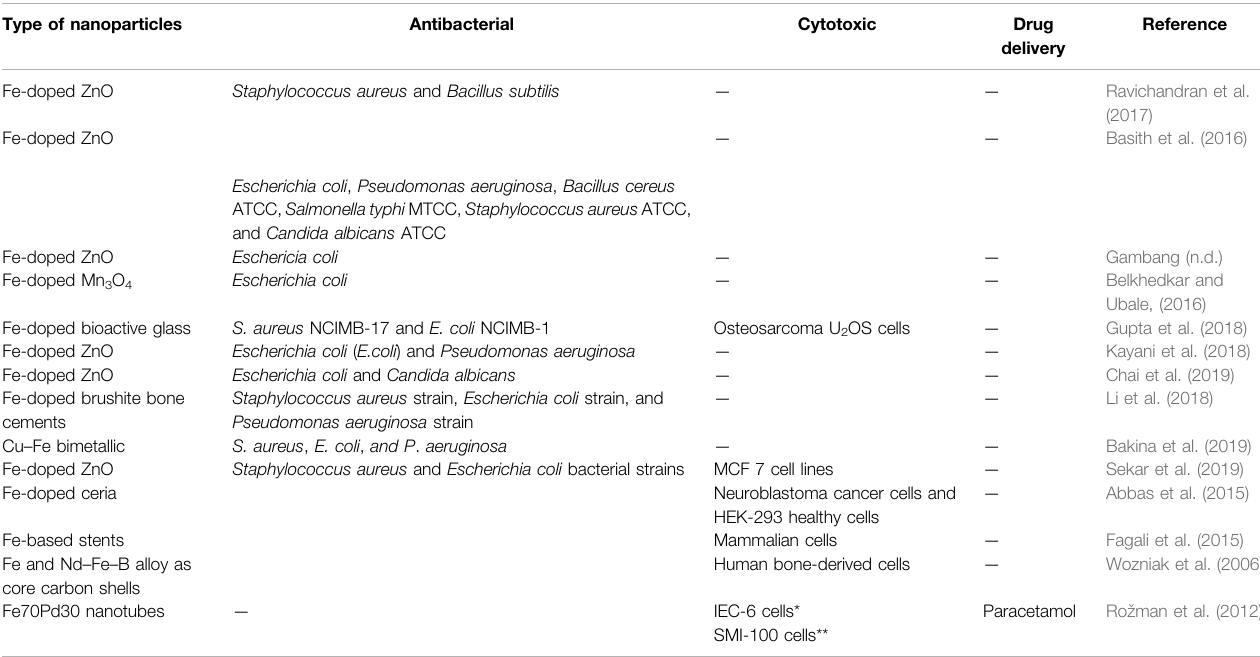
TABLE 3 | Some antibacterial, anticancer, and drug delivery applications of nanoparticles. Type of